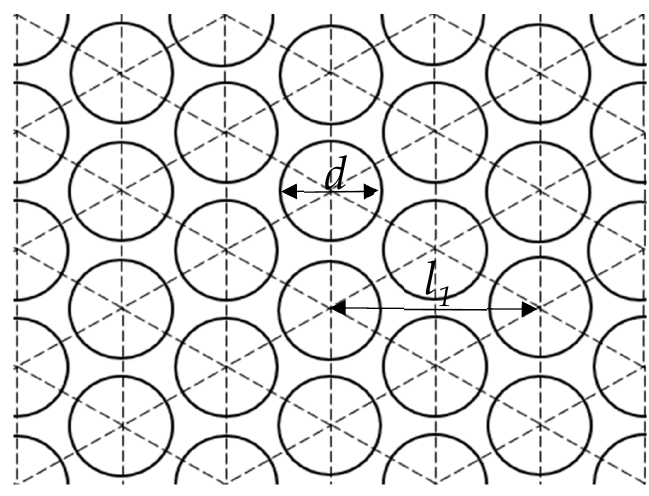
15 of 22 Figure 15. The 3D structure diagram of separation concave plate. 1. Connecting plate with the upper cap; 2. Perforated screen; 3. Arcuate side-plate; 4. Bolt hole. The screening e ff ect of the perforated screen is closely related to porosity of the screen, which is in fl uenced by the hole shape, size, and layout. Dandelion seeds resemble paddy rice in appearance, both of which are elliptic. Considering the shape and passing performance of seeds through the perforated screen, round screen holes were designed; because dandelion seeds are generally 0.30~0.47 cm long, the screen holes are circular with a diameter of 0.5 cm. The more porous the screen, the be tt er the screening e ff ect and the more seeds that pass through the screen. Therefore, screen holes are distributed in the form of equilateral triangles that enable high porosity (Figure 16). If the hole diameter d is 0.5 cm and the spacing between two adjacent holes l is 0.1 cm, the center-to-center spacing of two adjacent